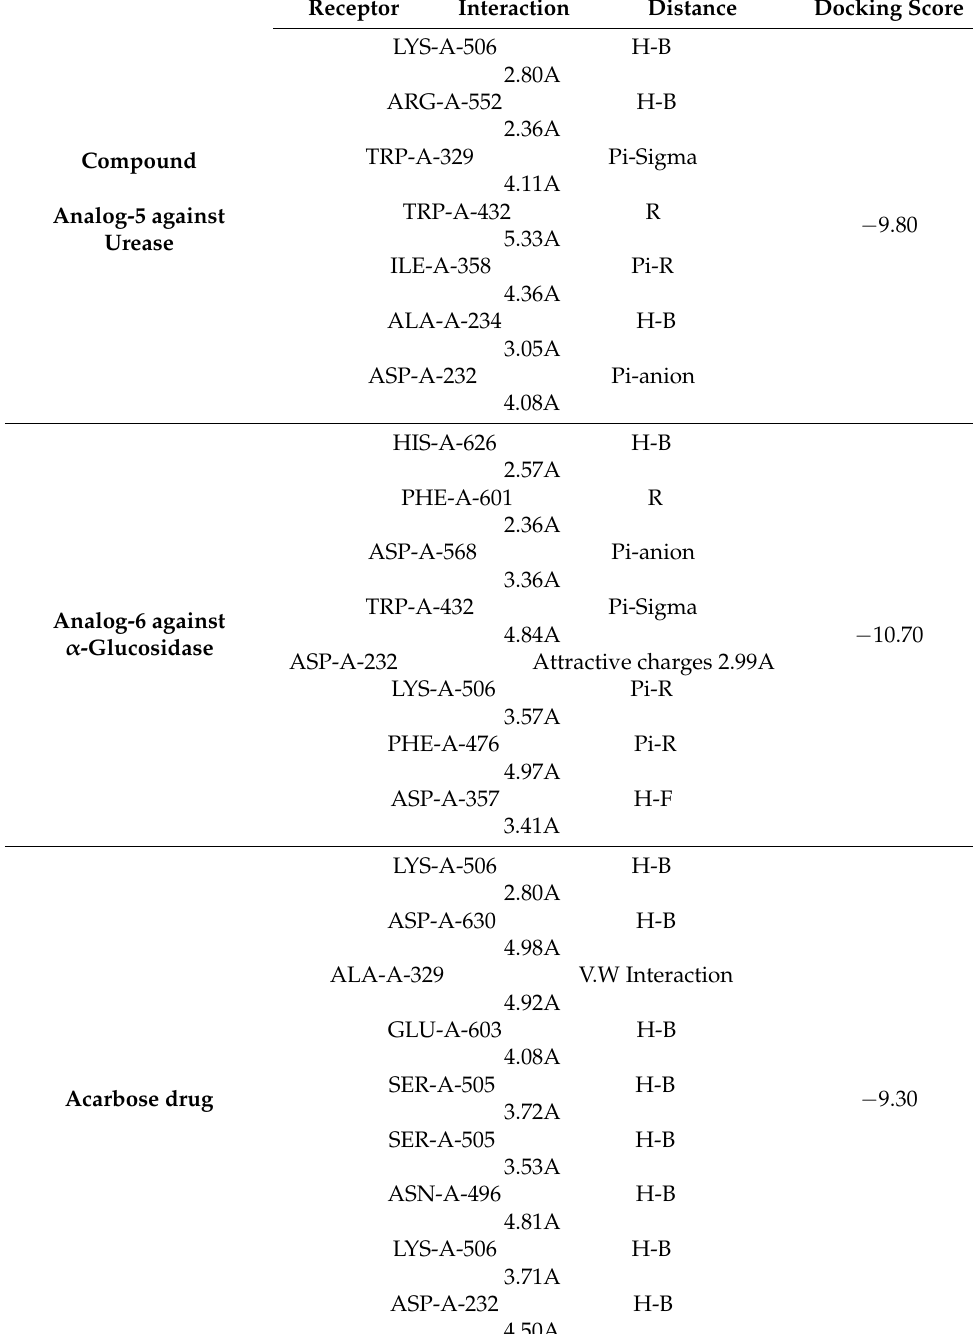
Table 2. The interactions of scaffolds 5 and 6 against urease and α -Glucosidase enzymes, respectively.